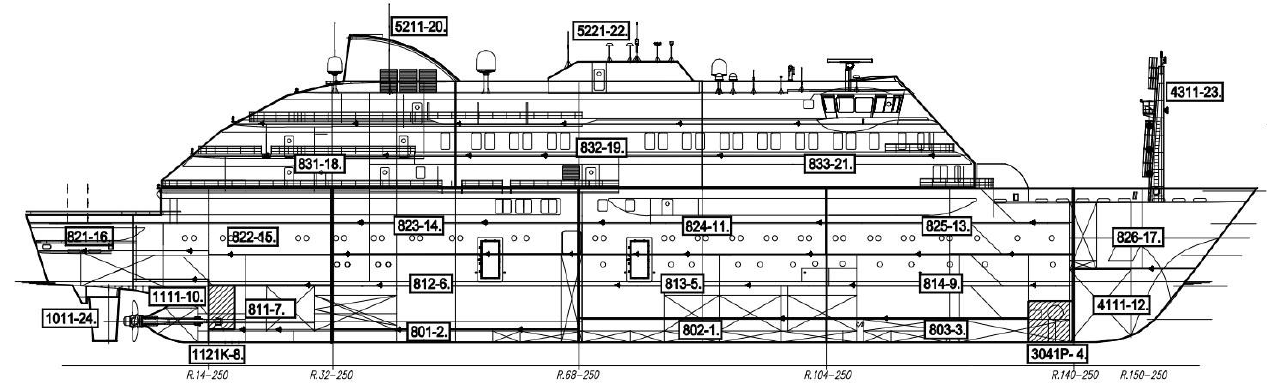
Figure 3. Technological division of the hull.